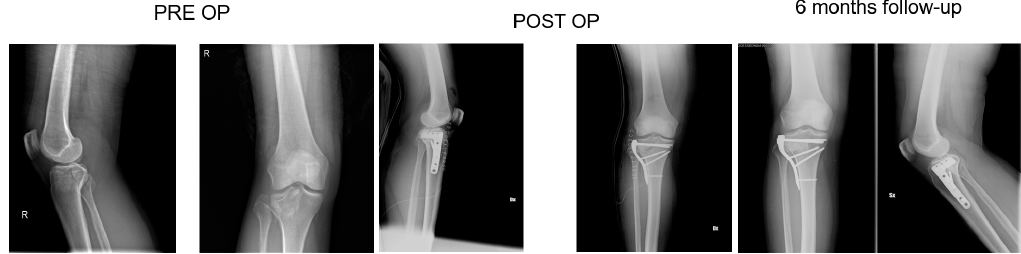
Figure 2. Sixty-year-old patient, X-rays: preoperative, postoperative and control at 6 months follow up of a Shatzker type 3 fracture, AO 41 B 1.3.